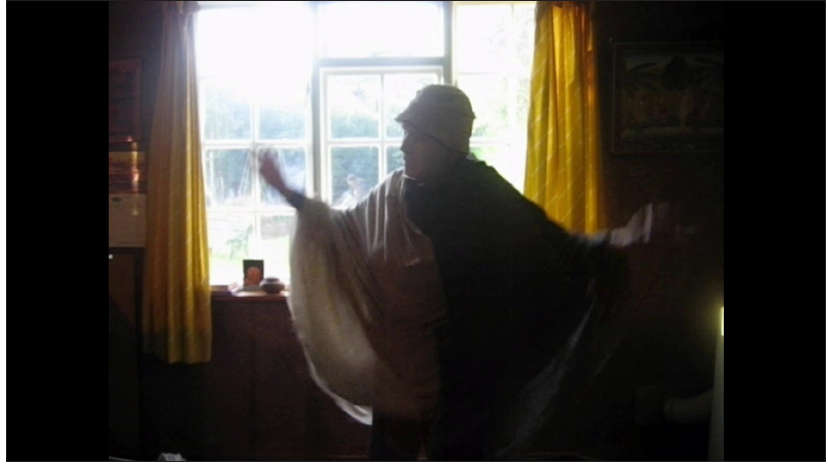
Figure 4.5: (10.54) Jennifer Pike with Veryan Weston, 2007. Courtesy of Veryan